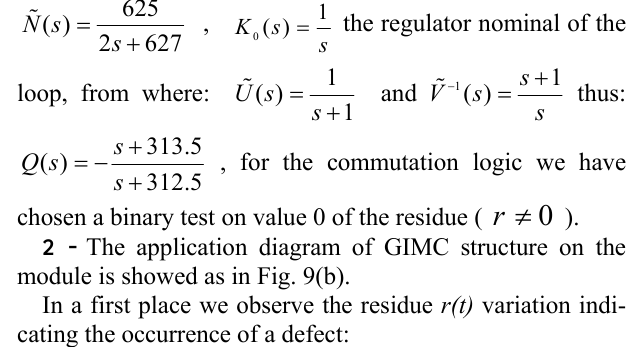
(t) and F (t ) d GIMC